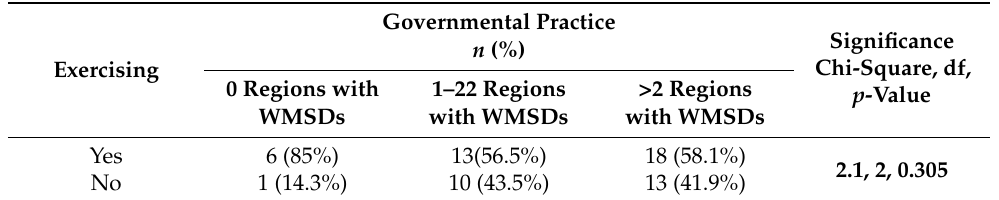
Table 5. A comparison between physical activities and the number of regions affected with WMSDs among dentists in governmental